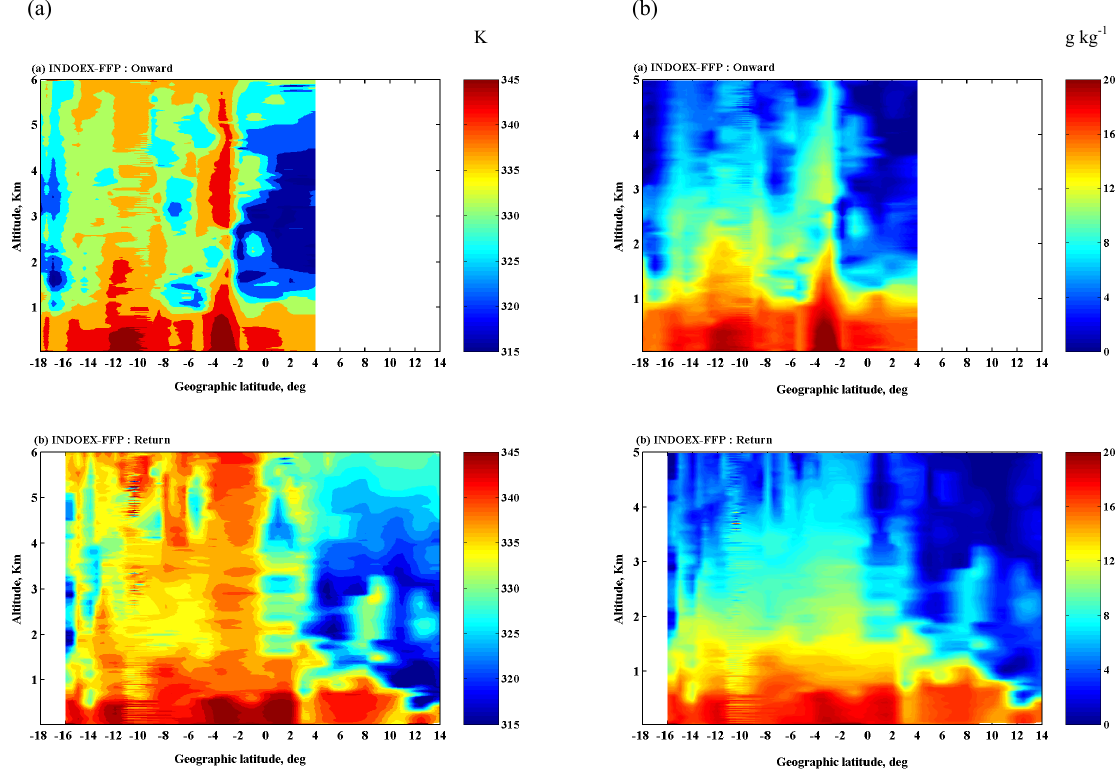
Fig. 9. Contour plots of (a) equivalent potential temperature and (b) mixing ratio over the entire latitude range during INDOEX-FFP. The boundary between red and blue is the trade wind inversion